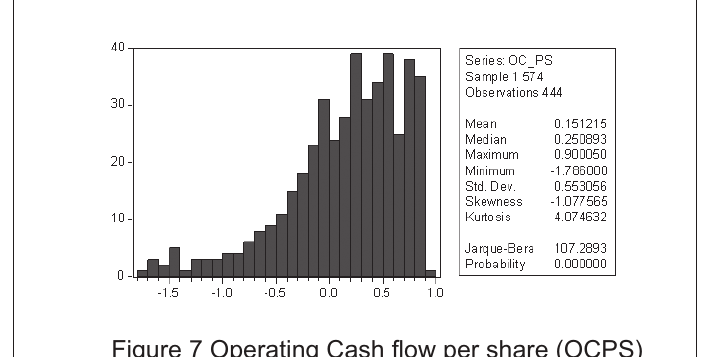
Figure 7 Operating Cash flow per share (OCPS)